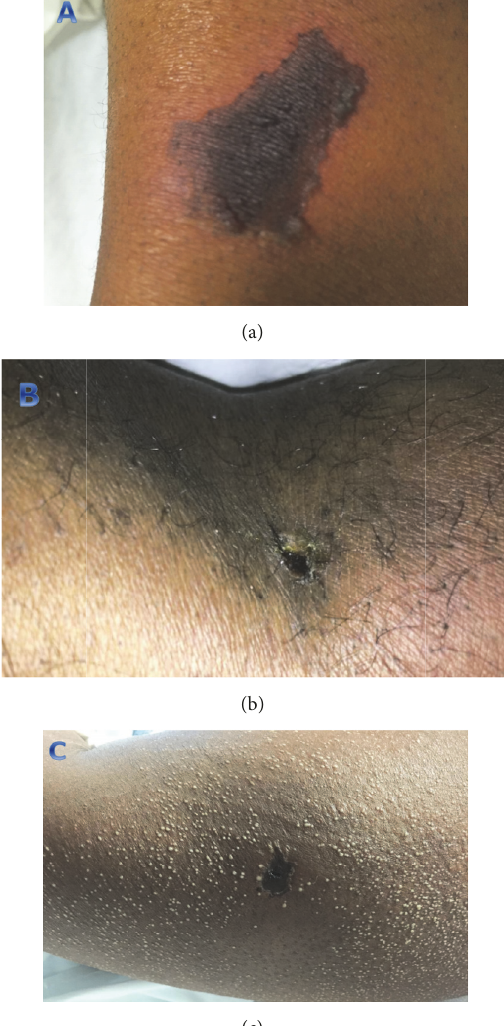
Figure 1: Recluse spider bite with skin necrosis. (a), (b): area of ecchymosis(a)andblackeschar(b)afterreclusespiderbite.(c)Black eschar surrounded by miliary rash as a result of recluse spider bite local